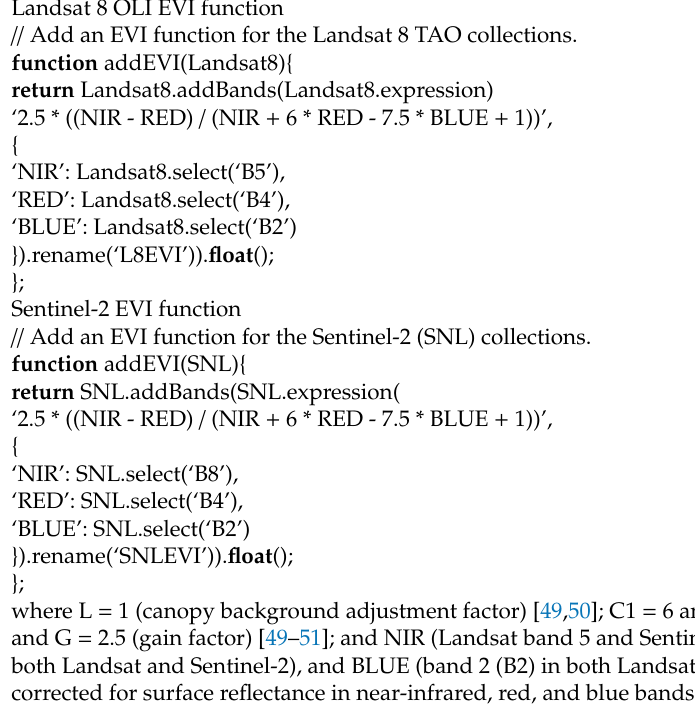
Table A1. GEE JavaScript function for calculating the Landsat 8 OLI